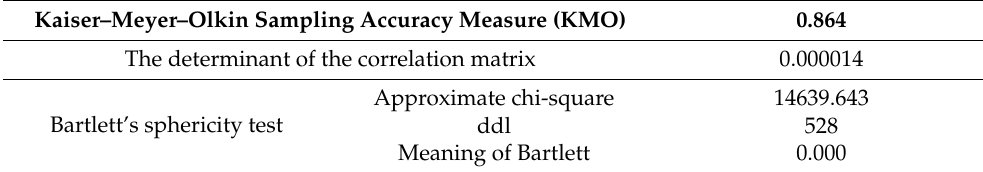
Table 5. Results of the PCA tests applied to the uses of ICT retained by the